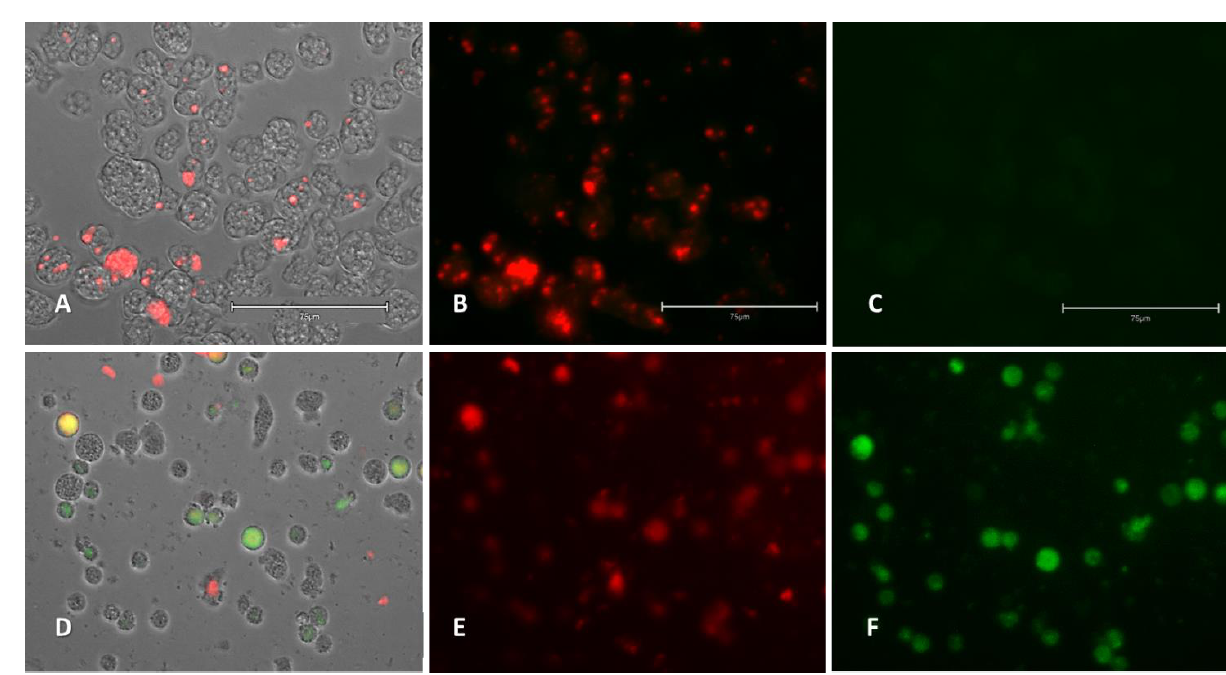
Figure 7. Effect of compound 3 ( D – F ) on the mitochondrial membrane potential against Naegleria fowleri (ATCC ® 30808™). Negative control ( A – C ) corresponds to Naegleria fowleri (ATCC ® 30808™) without treatment. JC-1 dye accumulates in the mitochondria of healthy cells as aggregates and emits red fluorescence (red channel: B – E ). Cells treated with the IC 90 of the compound for 24 h emitted green fluorescence (green channel: C – F ); due to the decrease in mitochondrial membrane potential, the JC-1 dye remained in the cytoplasm in monomeric form and emitted green fluorescence. Images (40×) are representative of the cell population observed in the performed experiments. Images were obtained using an EVOS™ M5000 Imaging System, Invitrogen by Thermo Fisher Scientific, Madrid, Spain. Scale bars represent 75 µm.